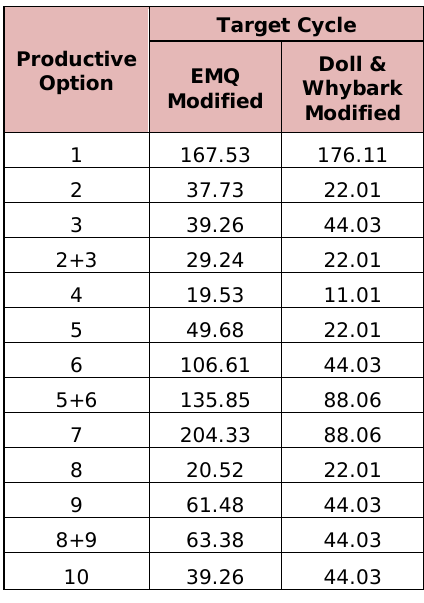
Table 1. “Target Cycle modified by incorporating